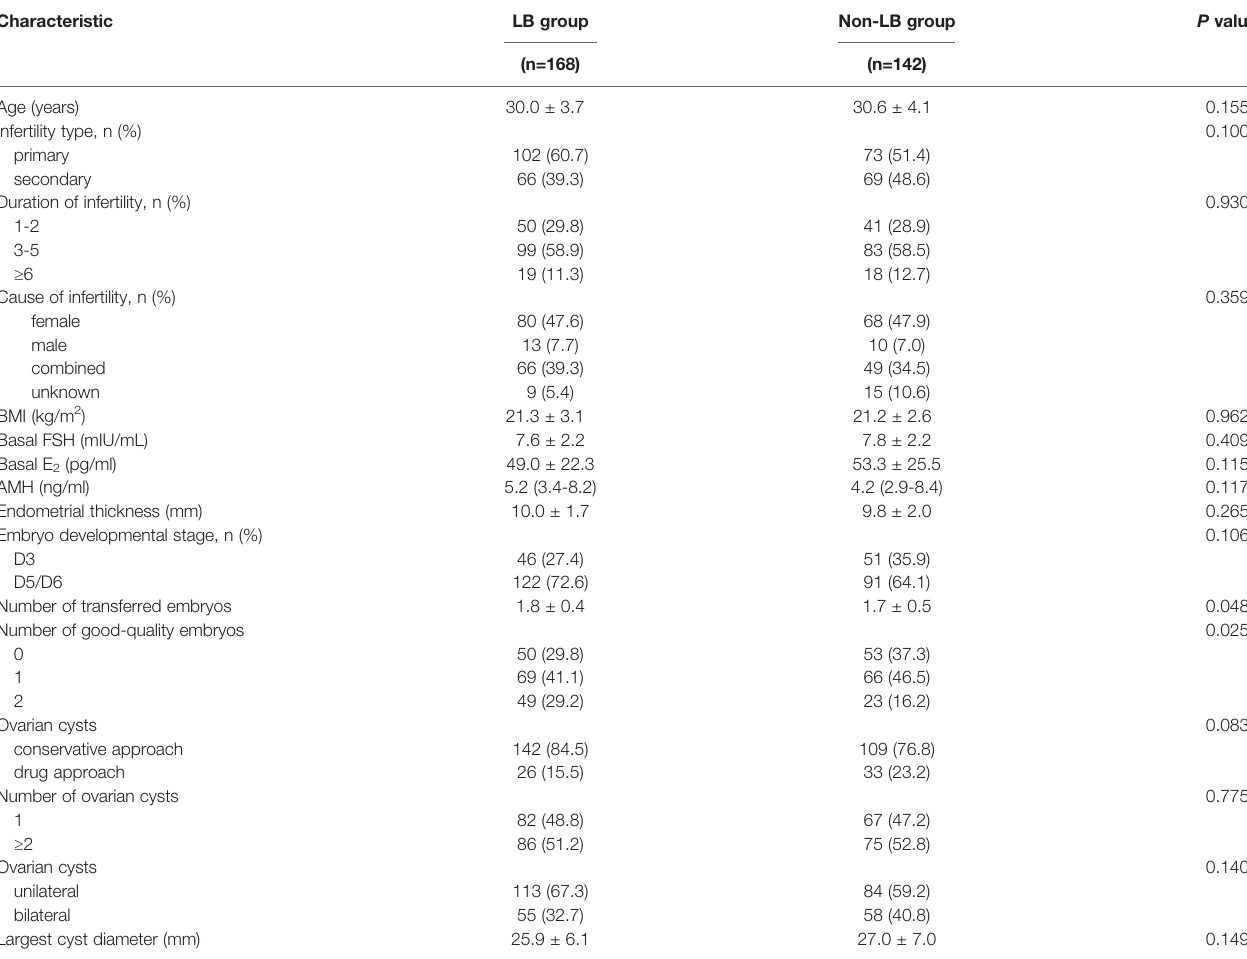
TABLE 6 | Characteristics between cycles reaching live births or failing to have live births under conservative and drug approach.